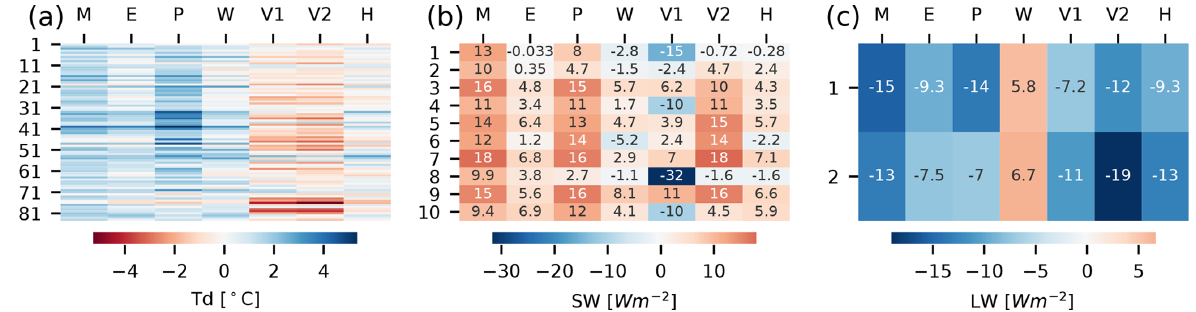
Figure 4. For each station, sorted from south to north ( y axis), and each model ( x axis) the differences between the modeled and observed station mean dew point temperature (a) , incident shortwave radiation (b) , and incident longwave radiation (c) are